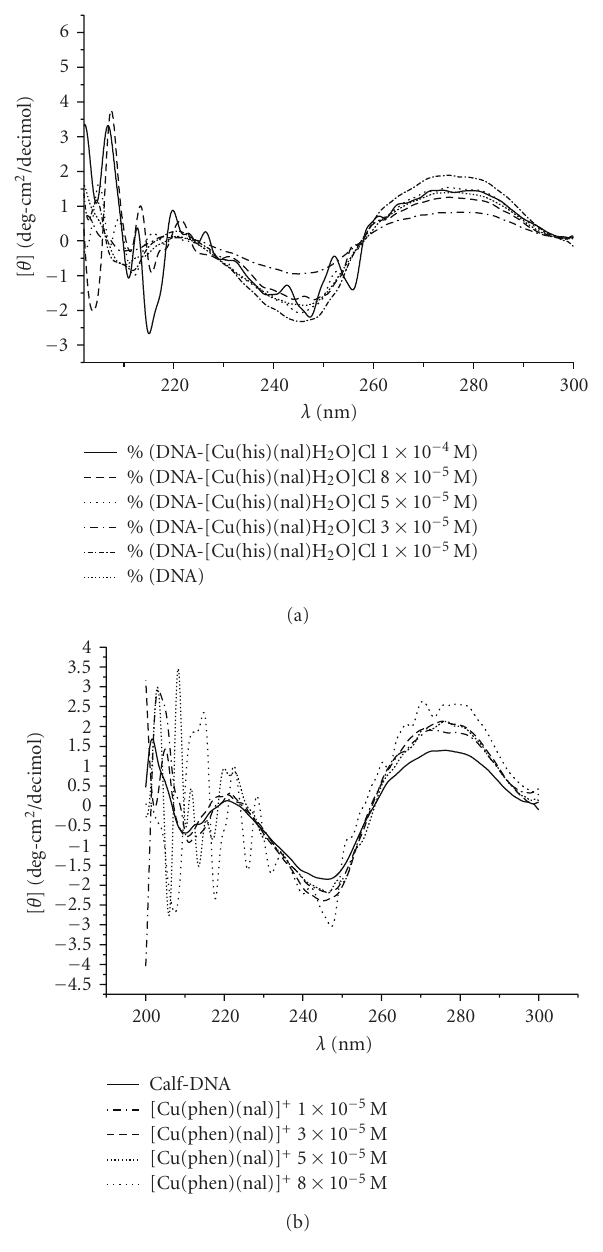
Figure 6: CD titration of CT-DNA with increasing amounts of the [Cu(hsm)(nal)H 2 O]Cl · 3H 2 O (a) and [Cu(phen)(nal)H 2 O]NO 3 · 3H 2 O (b) complexes at the following molar ratios: r = 0 . 0, 0.048, 0.14, 0.24, 0.38, and 0.48. (Complex/DNA). [DNA] = 2 . 07 x 10 − 4 M for all experiments.